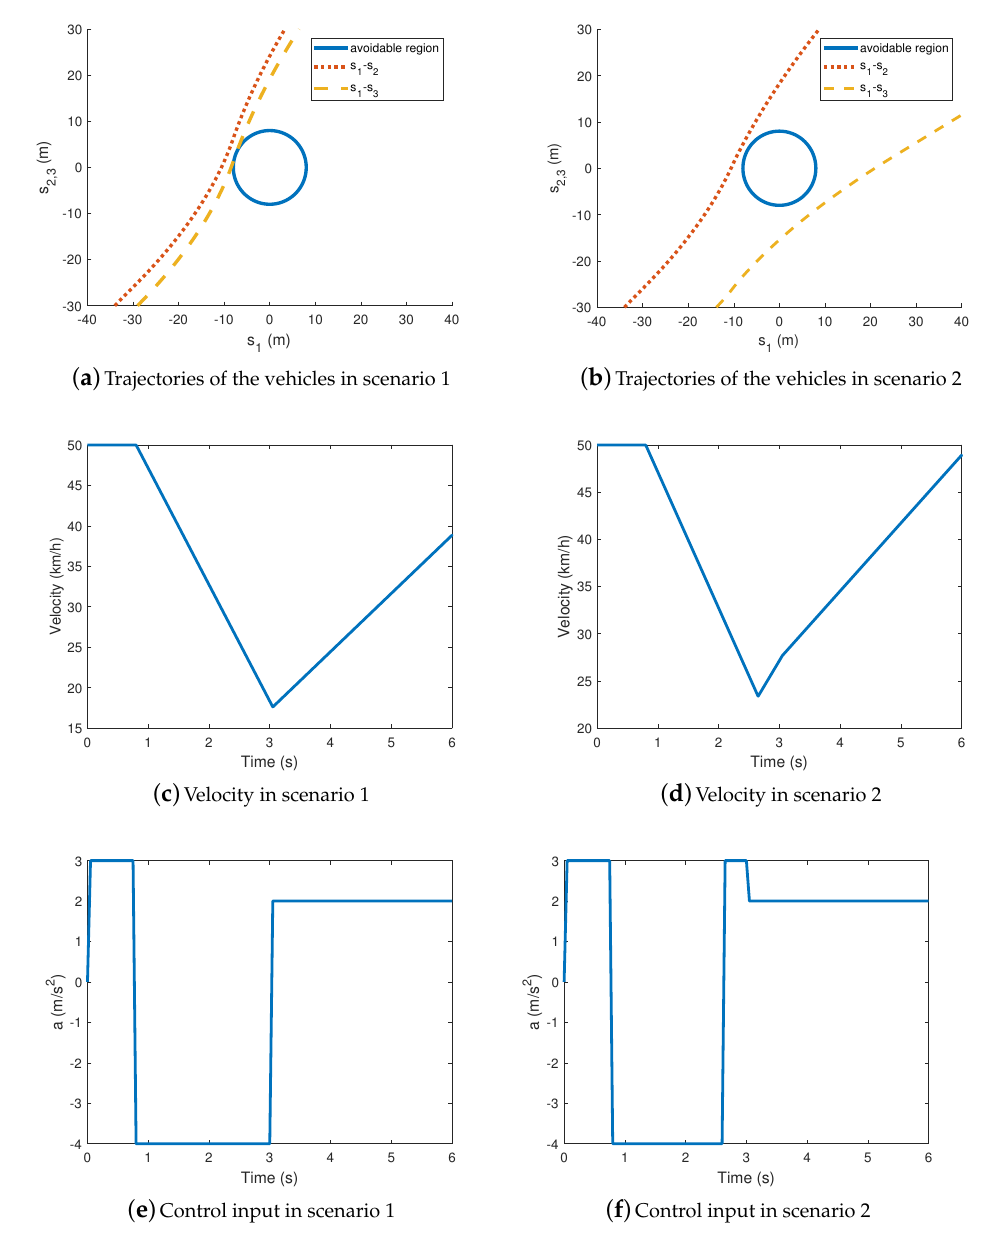
Figure 6. Signals of the simplified